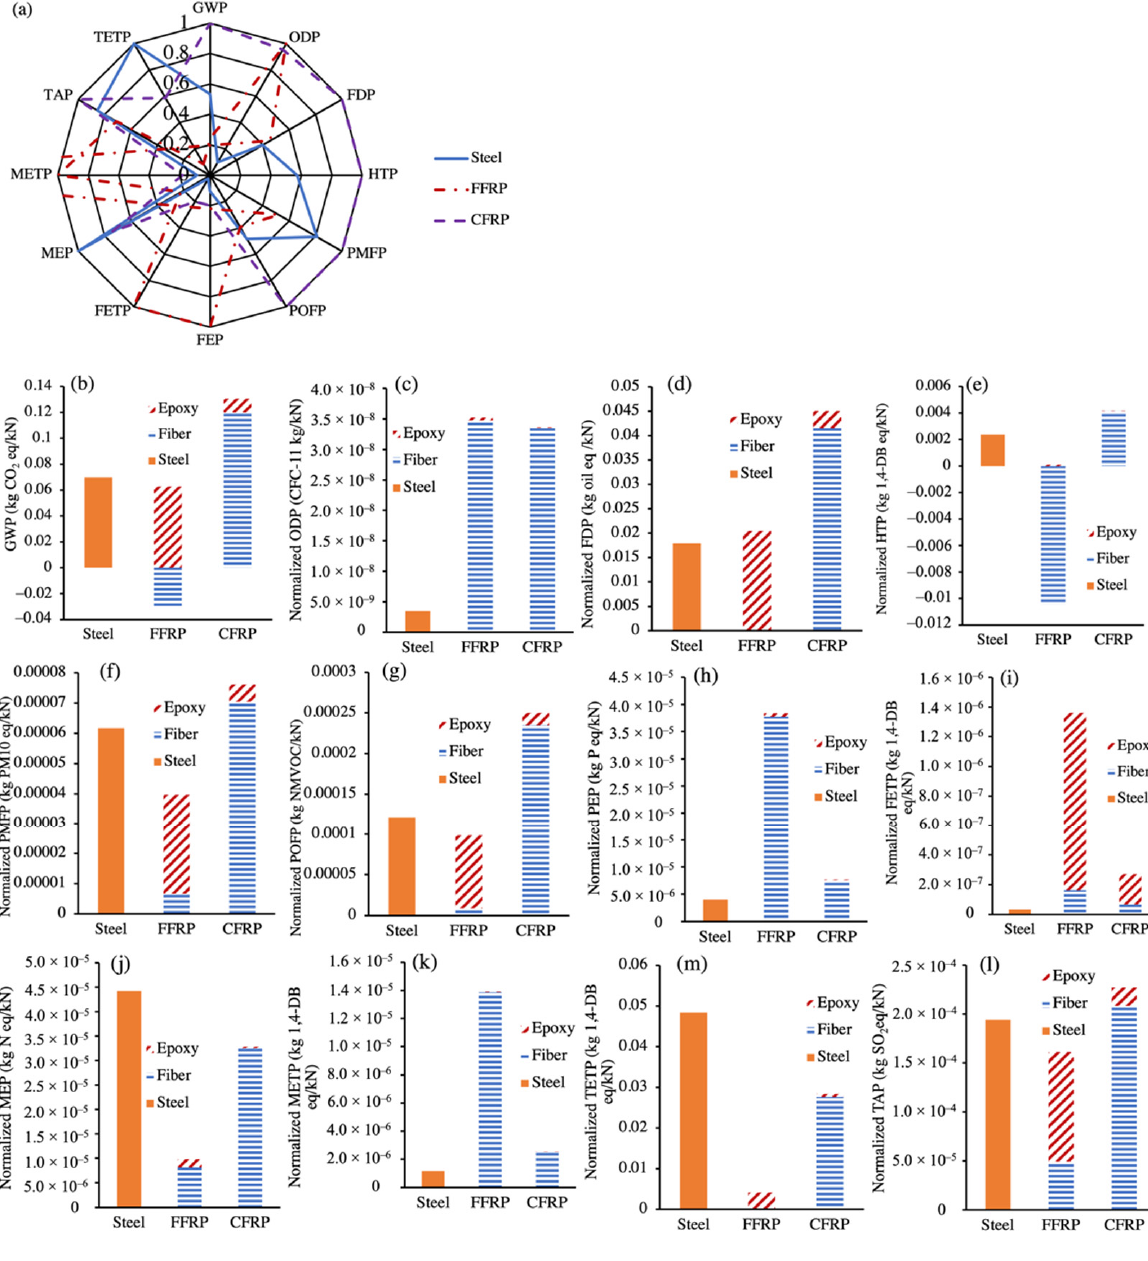
Figure 15. Environmental performance of steel, FFRP, and CFRP stirrups: ( a ) summary; ( b ) GWP; ( c ) ODP; ( d ) FDP; ( e ) HTP; ( f ) PMFP; ( g ) POFP; ( h ) PEP; ( i ) FETP; ( j ) MEP; ( k ) METP; ( m ) TETP ; and ( l ) TAP.